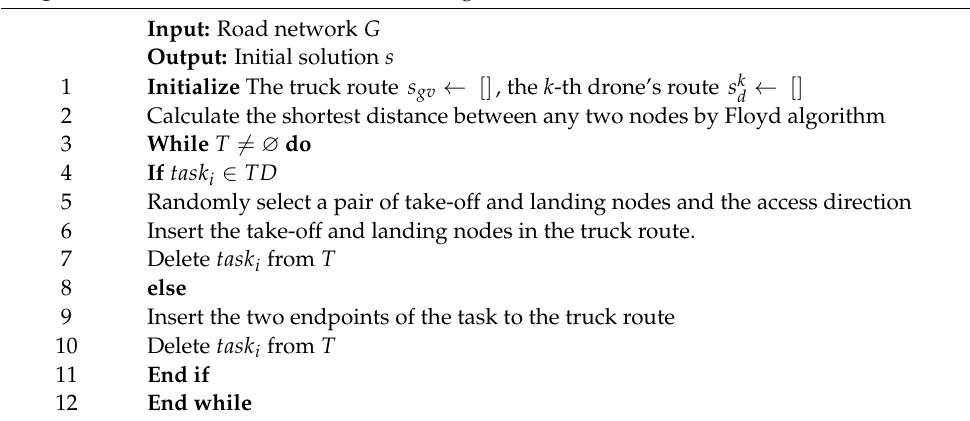
Algorithm 2: Heuristic method for initializing